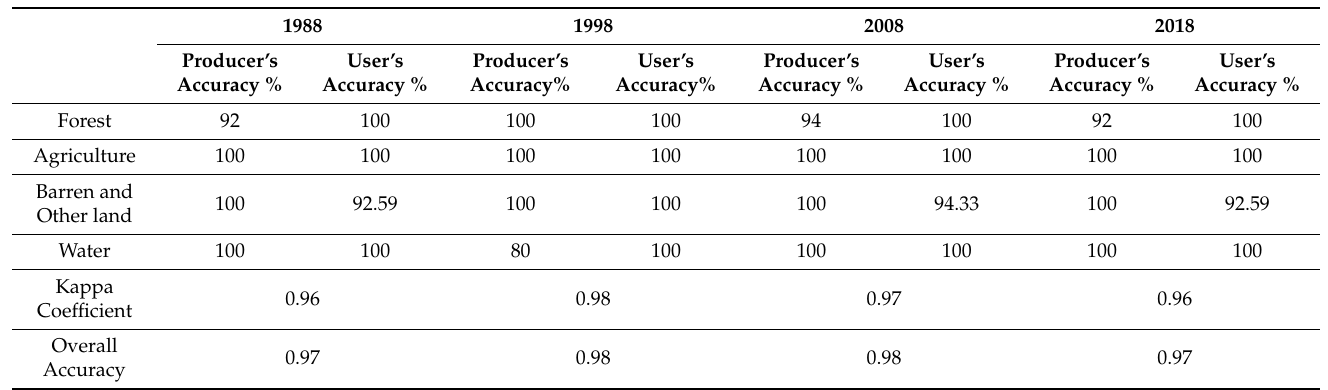
Table 3. Accuracy assessment of land use maps.